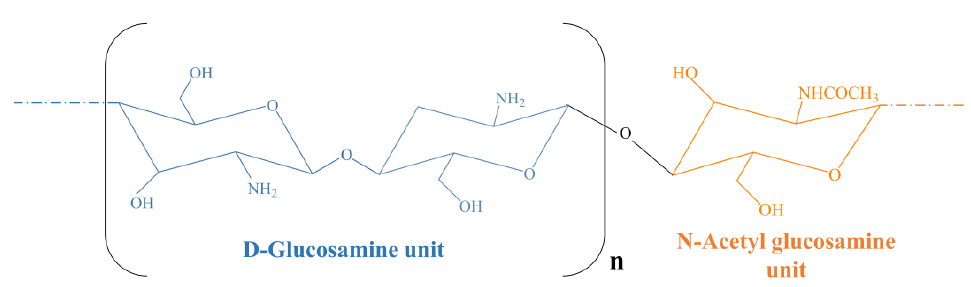
Figure 4. Chemical structure of chitosan.